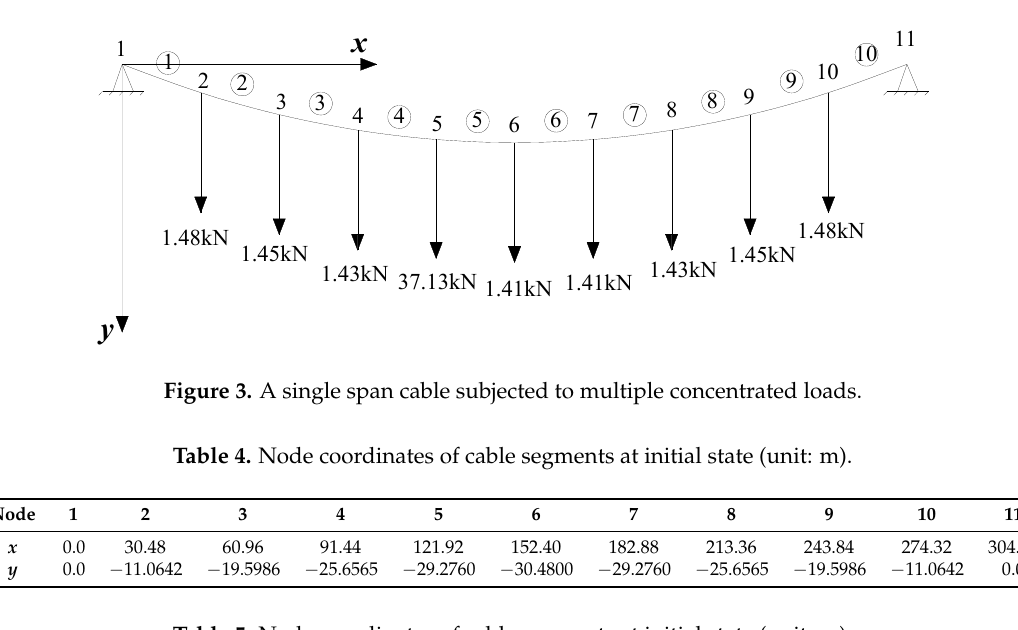
Table 5. Node coordinates of cable segments at initial state (unit: m).